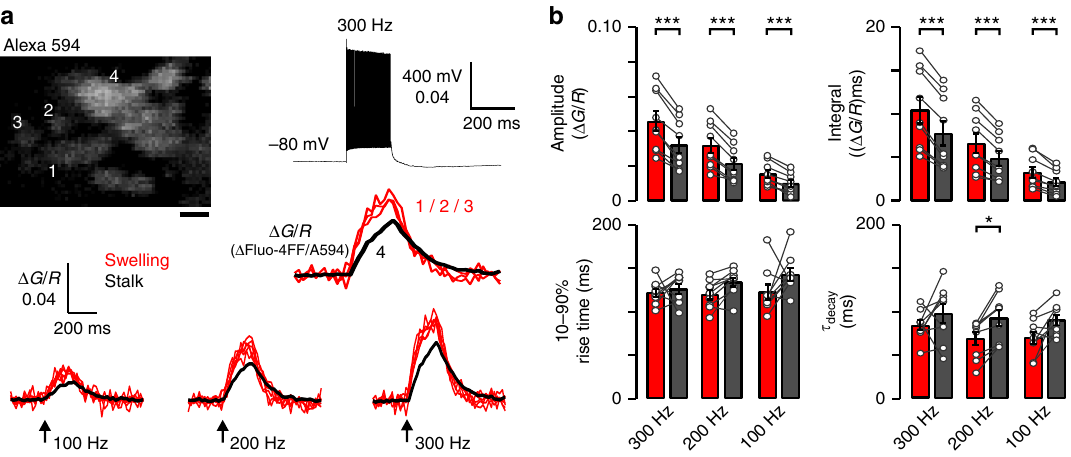
Fig. 8 Action potential train-evoked Ca 2 + transients are larger and faster in swellings than stalks. a Representative image outlines a calyx loaded with Fluo-4FF (50 μ M; K D = 9.2 μ M) and Alexa 594 (15 μ M) and frame-scanned by a two-photon laser scanning microscope. Action potential (AP) trains (100 – 300Hz, 200ms) were elicited by current injection in current-clamp mode or afferent stimulation using bipolar electrode. Ca 2 + transients were recorded in swellings (location 1, 2, 3; red) and stalk (location 4; black). Changes in [Ca 2 + ] were expressed as Δ G / R (see Methods). b Bar graphs (mean ±SEM) summarize amplitude, 10 – 90% rise time, decay time ( τ decay ), and integral (amplitude× τ decay ) of Ca 2 + transients in swellings (red; n = 9/8) and stalks (black; n = 9/8) at 100 – 300 Hz stimulation frequencies. Two-way repeated measures ANOVA with Bonferroni post hoc analyses was used to test signi fi cance. Critical p values were corrected by the number (3) of comparisons (* p <0.0166, *** p <0.0003). See Supplementary Table 3. Scale bar: 2 μ m ( a